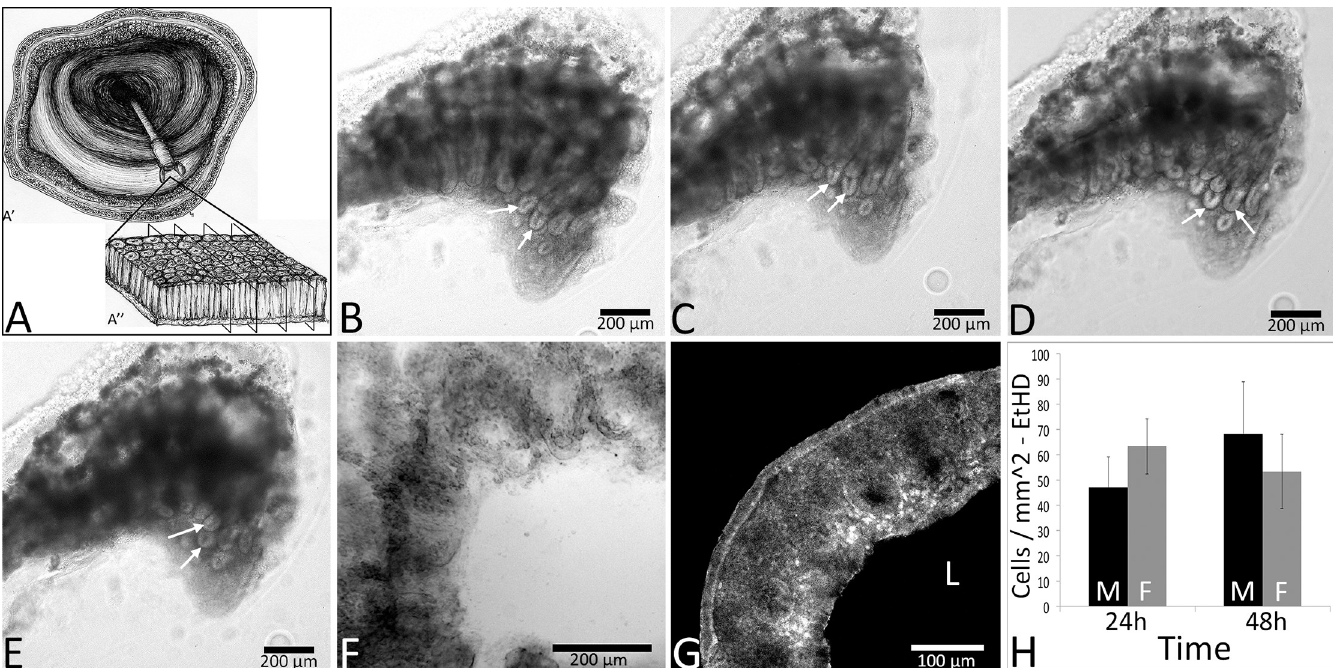
Fig 1. Structural integrity of organotypic colon biopsy slices (schematic in A) was maintained for up to 3 days ex vivo. Bright-field images of one organotypic biopsy slice at 0 (B), 24 (C), 48 (D) and 72h (E) ex vivo show intact colonic crypts and lamina propria. Crypt enterocytes were organized at the luminal surface (arrows). A representative slice is shown at 96h ex vivo with tissue degradation that rendered crypt patterning difficult to identify (F). A representative image shows minimal cell death (EtHD label; RFP; G) at 48h ex vivo. No differences were seen in EtHD label between 24 and 48h of culture regardless of sex (H). Data in panel H are +/- SEM, n = 3 male and 3 female participants per time point. Black bars in panel H represent males (M), and gray bars females (F). ‘L’ represents the luminal aspect.